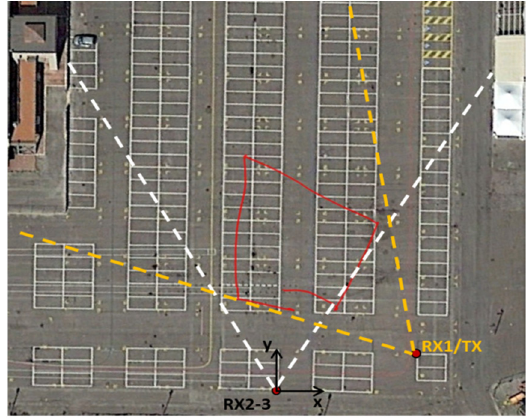
Figure 15. Experimental setup and nominal path for the drone test case.